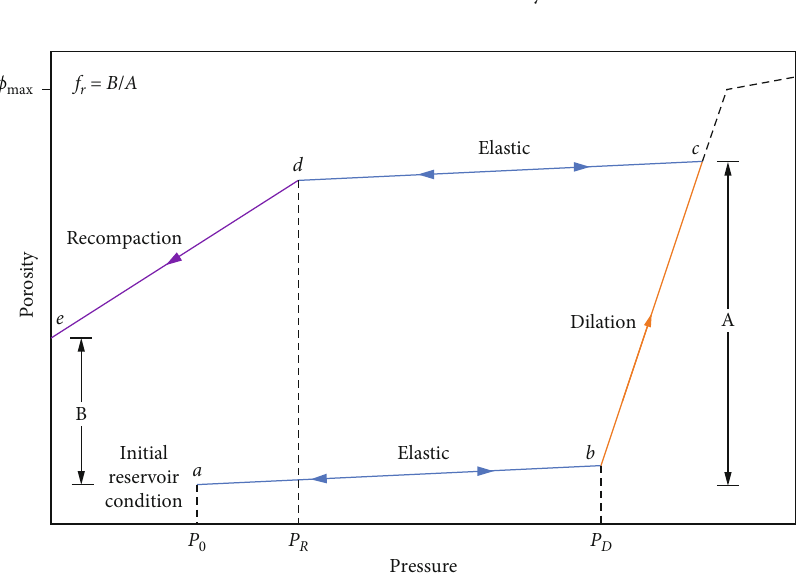
Figure 2: Dilation-recompaction model [9].